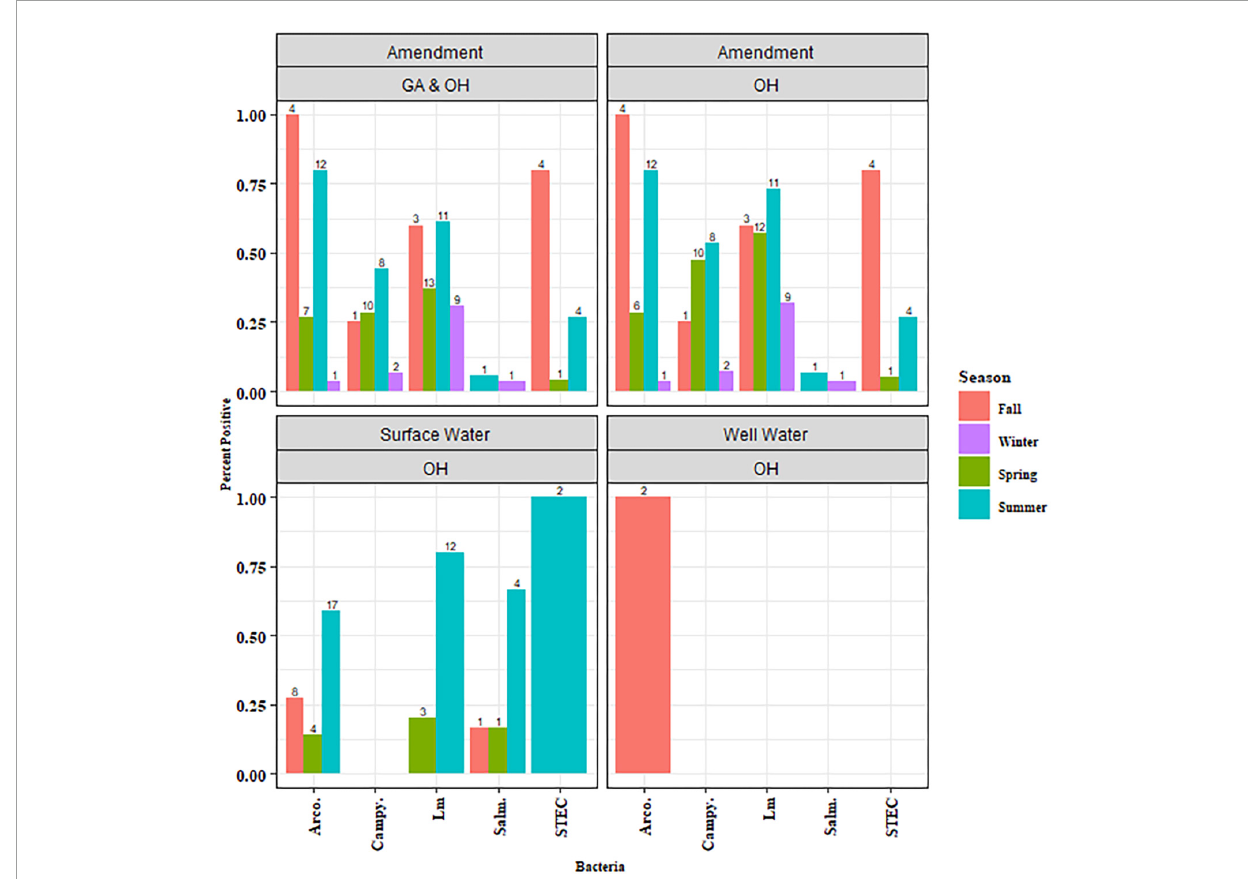
FIGURE3 Pathogen prevalence in amendment and water samples by season. Amendment includes the actual BSA applied to fields as well as dairy manure samples that were not associated with field application. Data is plotted to show the percent of the samples tested that were positive for the indicated pathogen evaluated within each